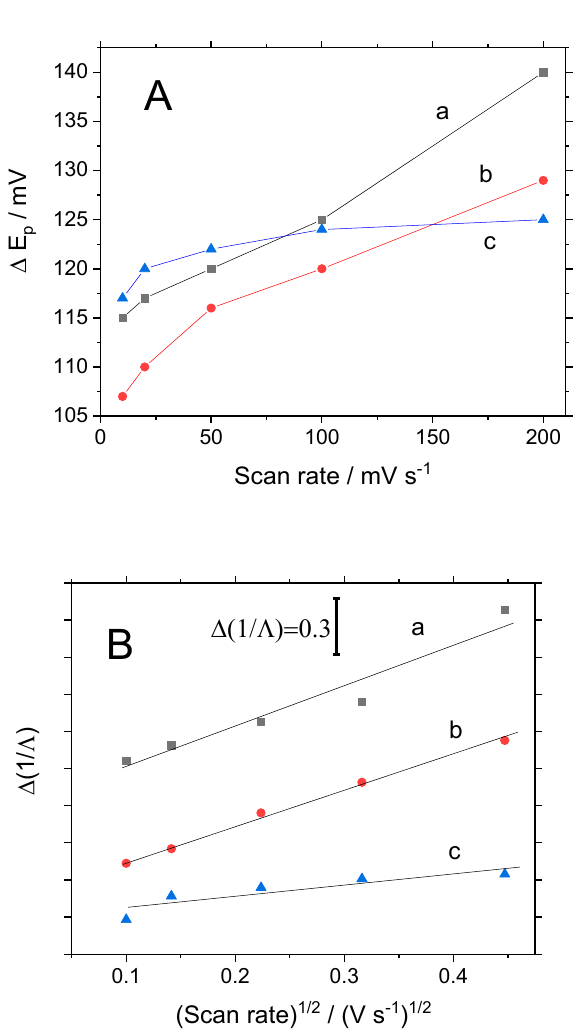
Figure 4. ( A ) Voltammetric peak potential separation between oxidation and reduction process of ferrocene as a function of the voltammetric scan rate for different electrodes. ( B ) Variation of the reciprocal of the Matsuda–Ayabe Λ parameter as a function of the square root of the voltammetric scan rate for different glassy carbon (GC) ‐ modified electrodes. ( a ) SiO 2 ; ( b ) SWCNT@SiO 2 ; ( c )